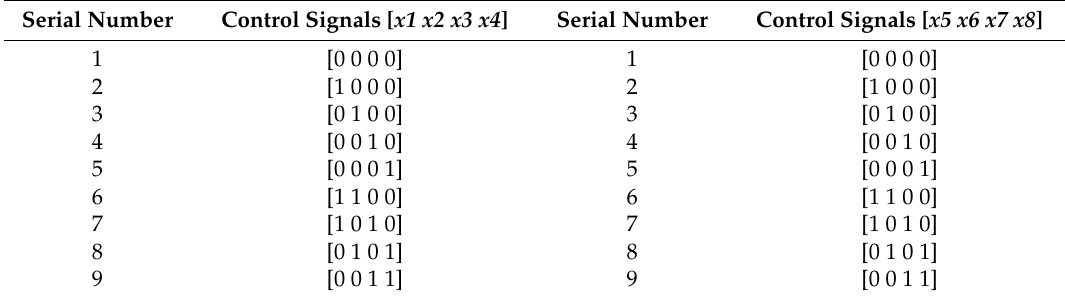
Table 2. The control signal combinations for the reversing